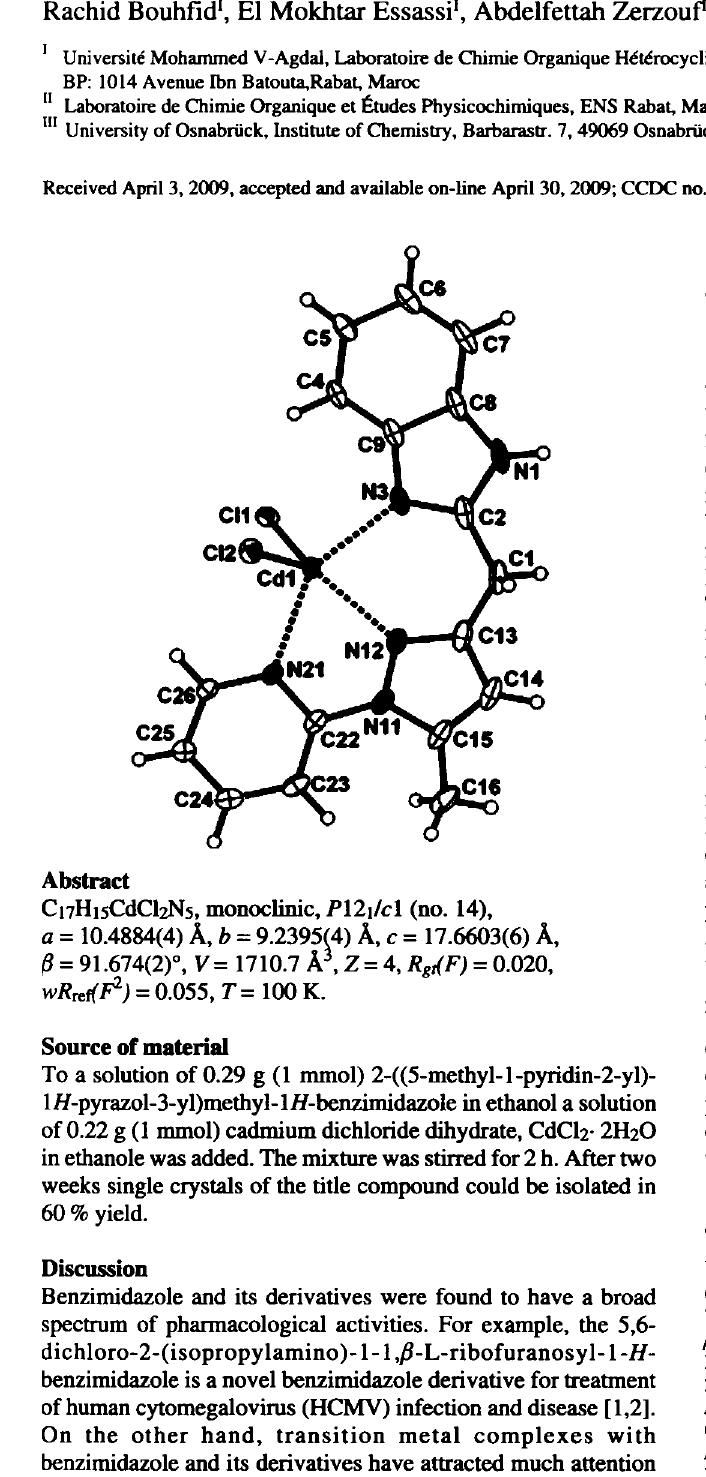
Table 1. Data collection and handling.